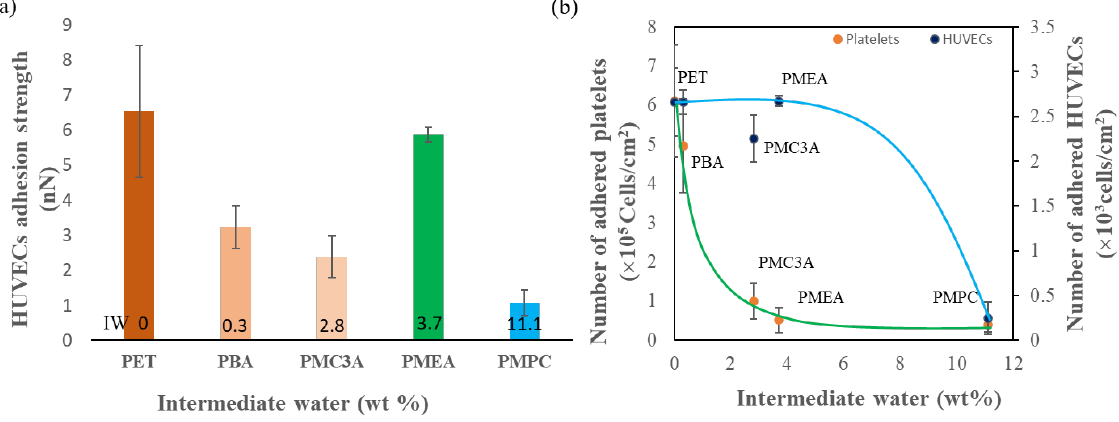
Figure 8. Effect of IW content on ( a ) HUVECs adhesion strength and ( b ) number of adhered platelets and HUVECs on PMEA-analogous polymers.